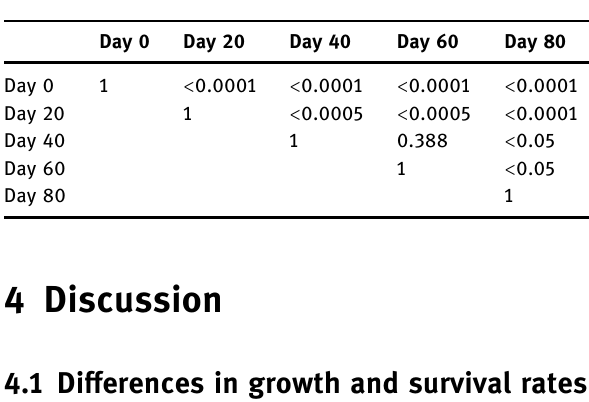
Table 2: Statistical results ( p - value ) of body weight in the fresh - water giant prawn Macrobrachium rosenbergii between 20 - day